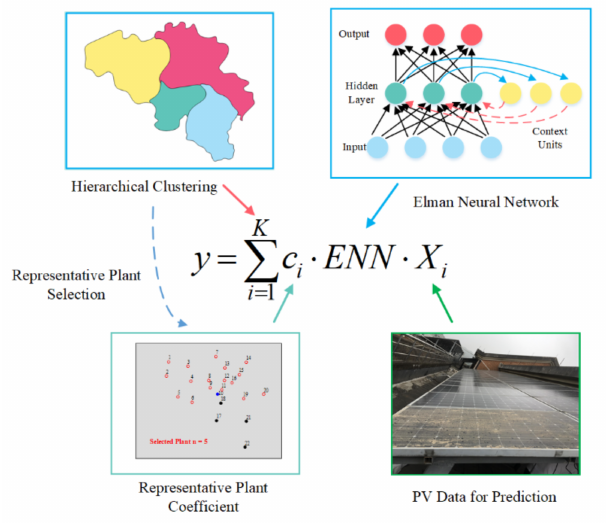
Figure 5. Main schematic diagram of the proposed